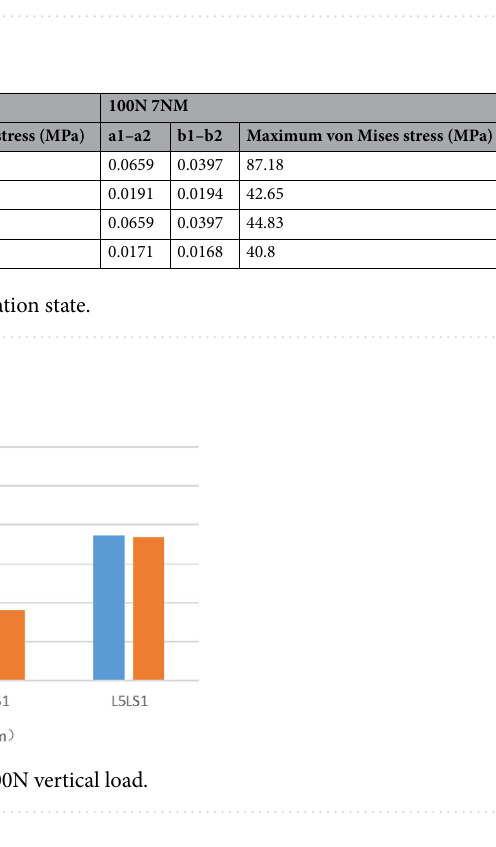
Table 6. Tukey HSD test. Tukey HSD pairwise comparisons for variable group studentized range critical value (0.05, 4 , 16) = 4.0460967 uses harmonic mean sample size = 5.000. Group 1 L4L5NS1, Group 2 L5NS1, Group 3